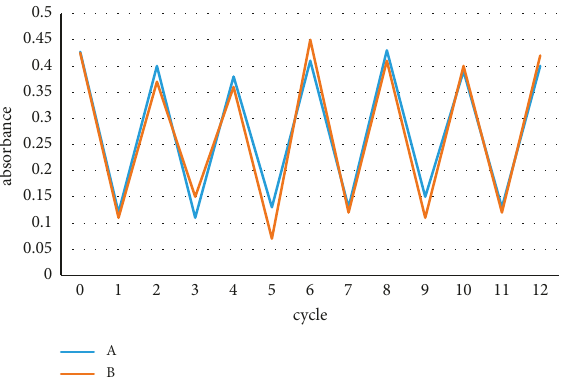
Figure 11: Comparison of fatigue resistance of polymers.